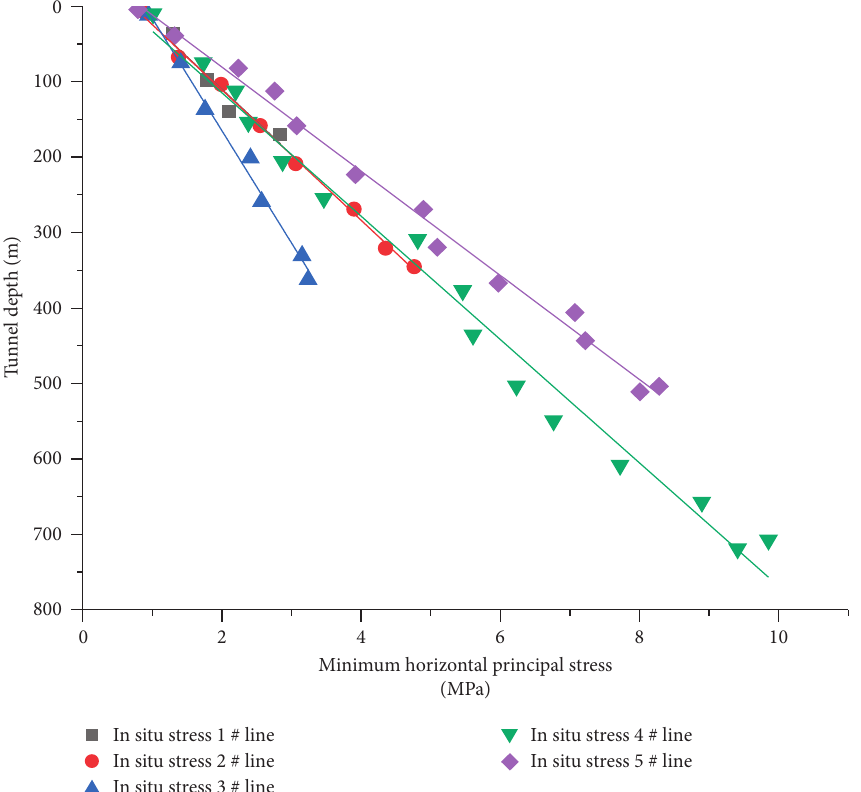
Figure 3: Variation characteristics of minimum horizontal in situ stress with depth.